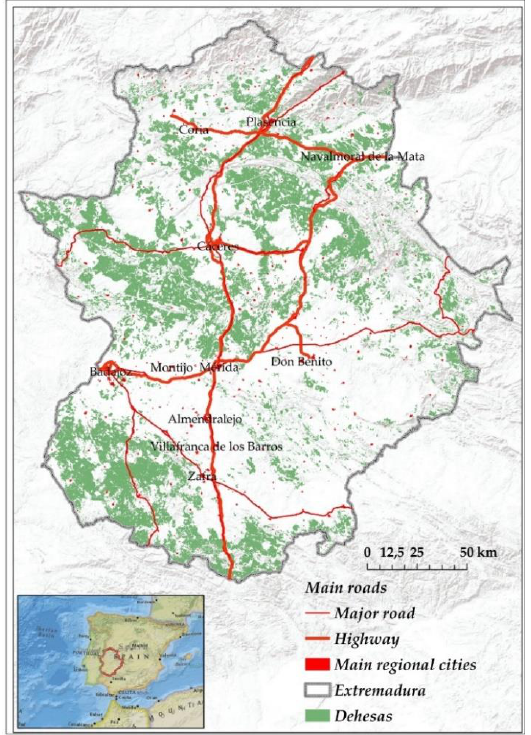
Figure 1. Locations of dehesas.